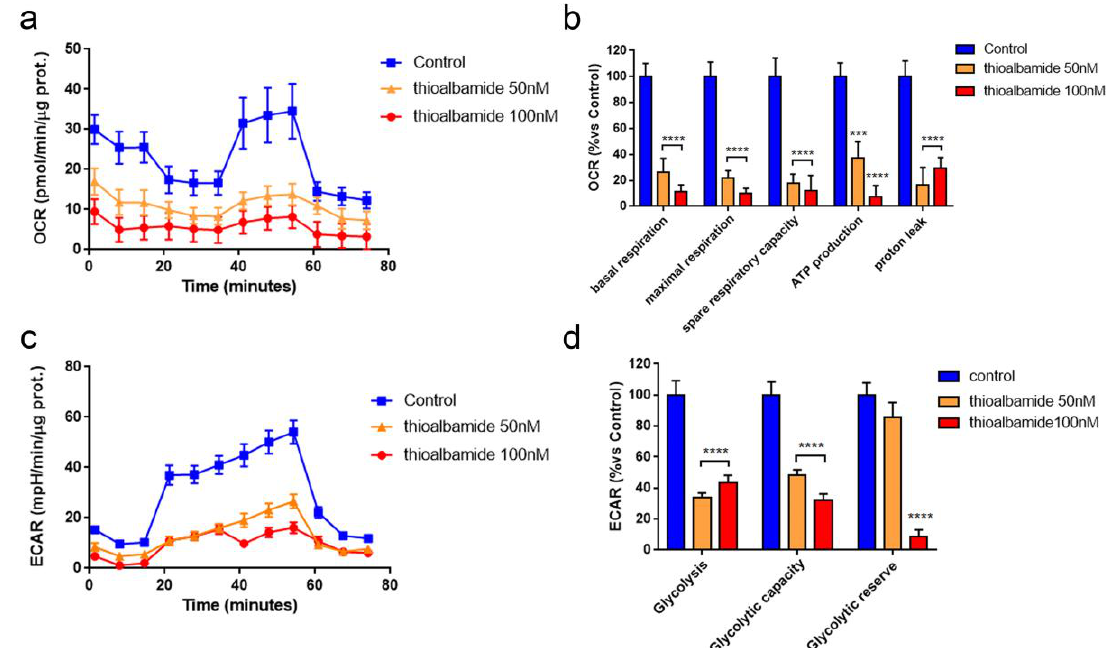
Figure 6. Thioalbamide inhibits metabolic functions in MCF7 cells. A Seahorse XFe96 analyzer was employed to analyze mitochondrial respiration and glycolytic function in MCF7 cells treated with thioalbamide for 48 h by monitoring oxygen consumption rate (OCR) and the extracellular acidification rate (ECAR), respectively. ( a ) OCR representative tracings of MCF7 cells treated with DMSO (control) or 50–100 nM thioalbamide. ( b ) Histograms of mitochondrial respiration parameters. ( c ) ECAR representative tracings of MCF7 cells treated with DMSO (control) and 50–100 nM thioalbamide. ( d ) Histograms of glycolytic function parameters. Significant reductions of mitochondrial and glycolytic function were observed experimentally. Values represent the mean ± SEM of five biological replicates of three independent experiments. *** P value < 0.001; **** P value < 0.0001.